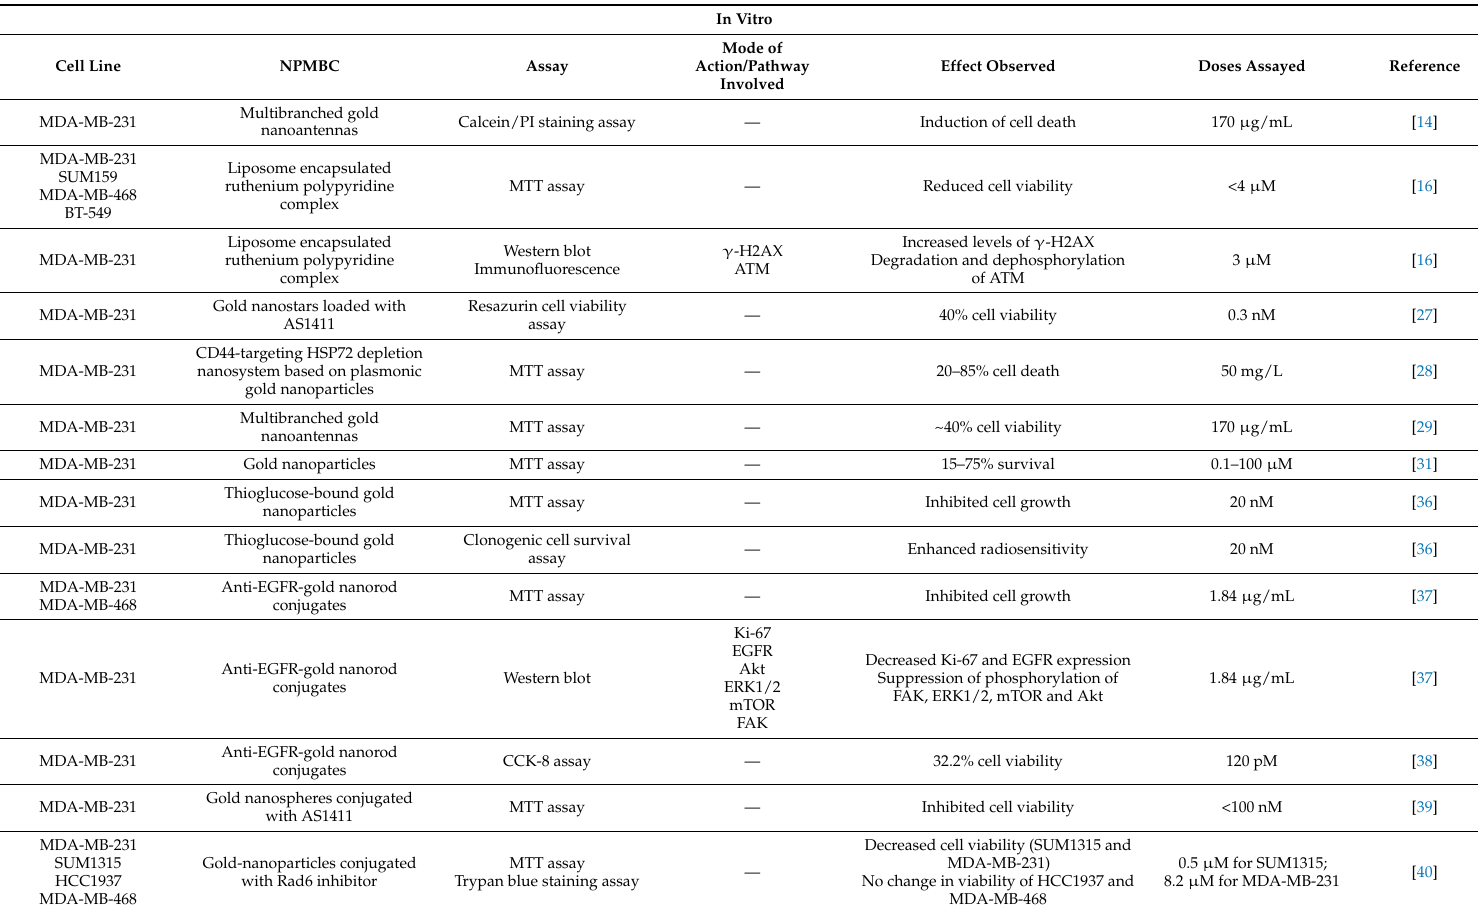
Table 2. Non-platinum metal based complexes (NPMBC) inhibit the in vitro and in vivo growth of triple-negative breast cancer (TNBC) cells by inhibiting tumor cell